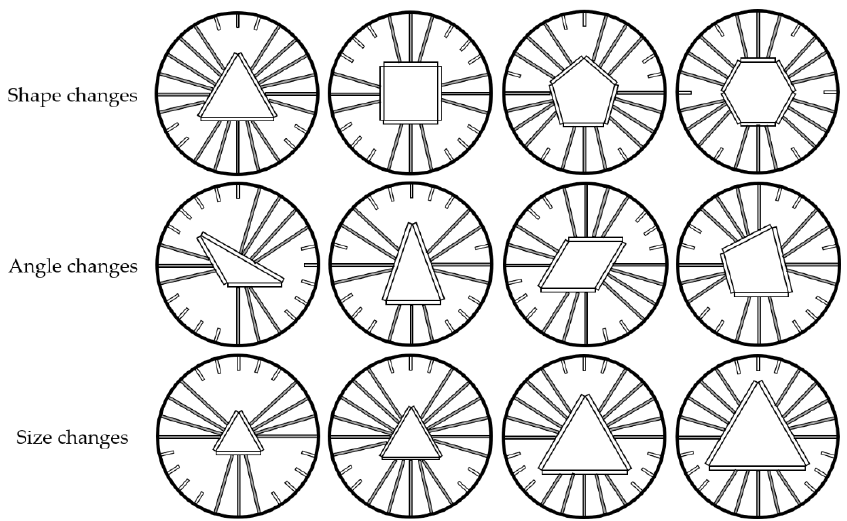
Figure 10. Side mold control equipment that implements various shapes of FCP.